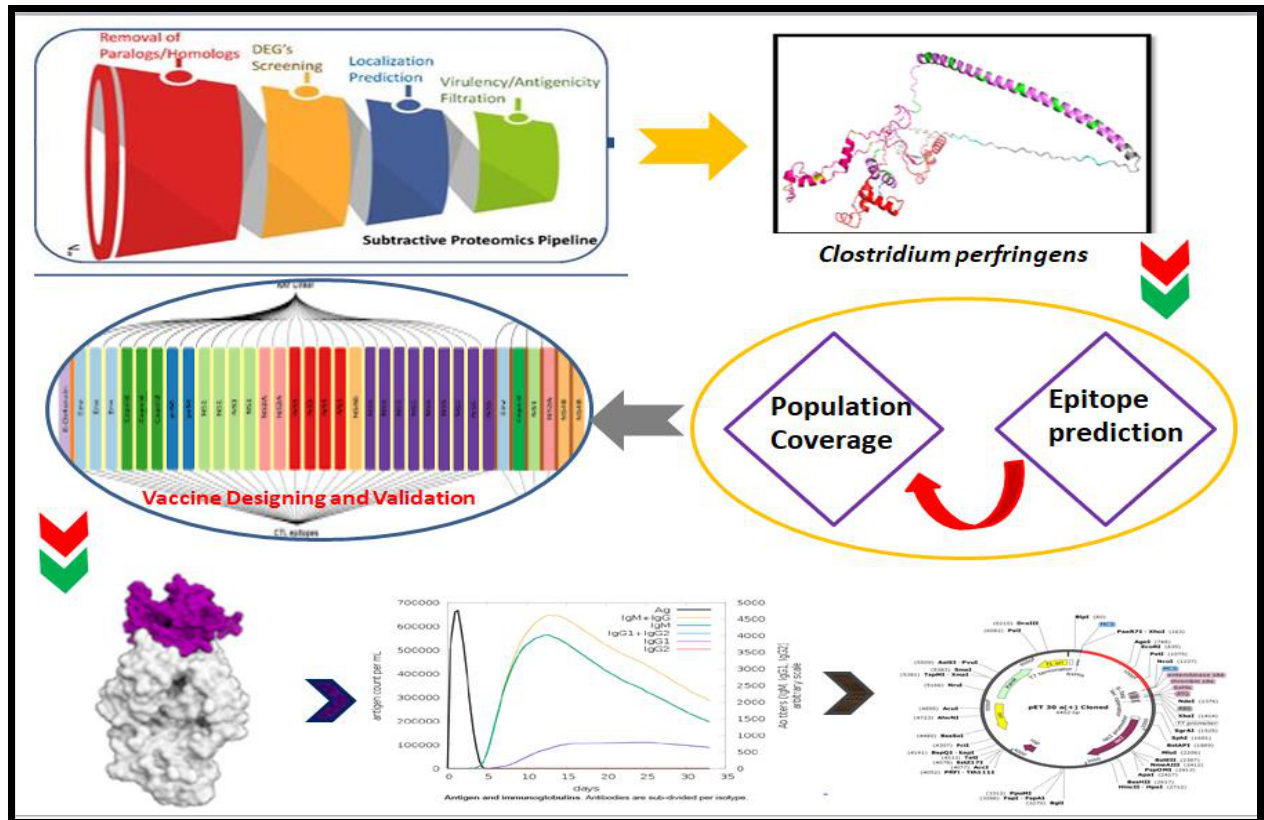
Figure 1. The Graphical abstract of the subtractive genomics-assisted pipeline utilized in this current study includes: whole proteome retrieval, removal of paralogs, essential gene retrieval, virulence factor identification, antigenicity prediction, subcellular location, CTL, HTL and B-cell epitope prediction and validation, vaccine construction, secondary and tertiary structure prediction and validation, molecular docking of MEV with TLR4 complex, MD simulation and immune-simulation, and in silico cloning.